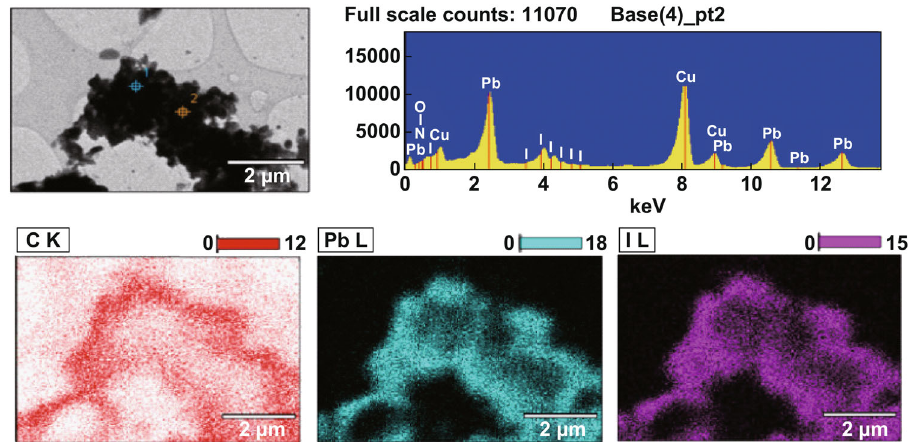
Fig. 7 Plots of three consecutive measurements of DLS with Zeta Potential which is performed in isopropanol suspensions of the CH 3 NH 3 PbI perovskite at 20 min sonication [109]